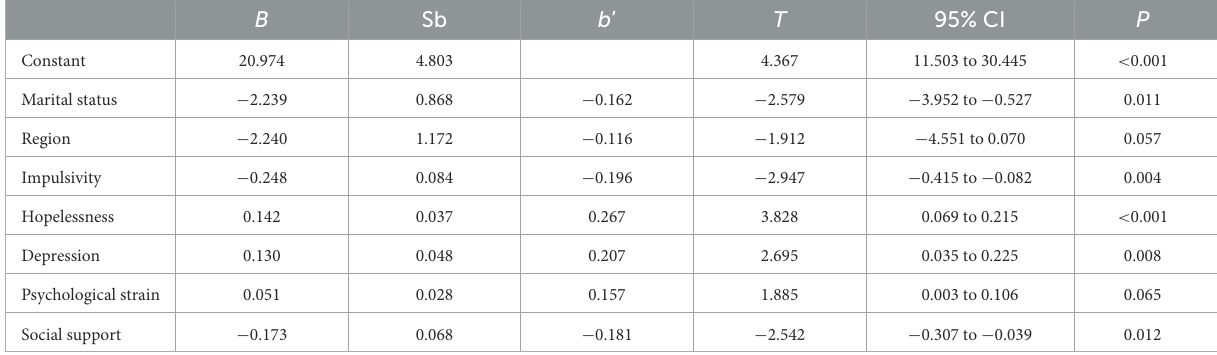
TABLE 5 Multiple linear regression analysis evaluating influencing factors for suicidal intent ( n =